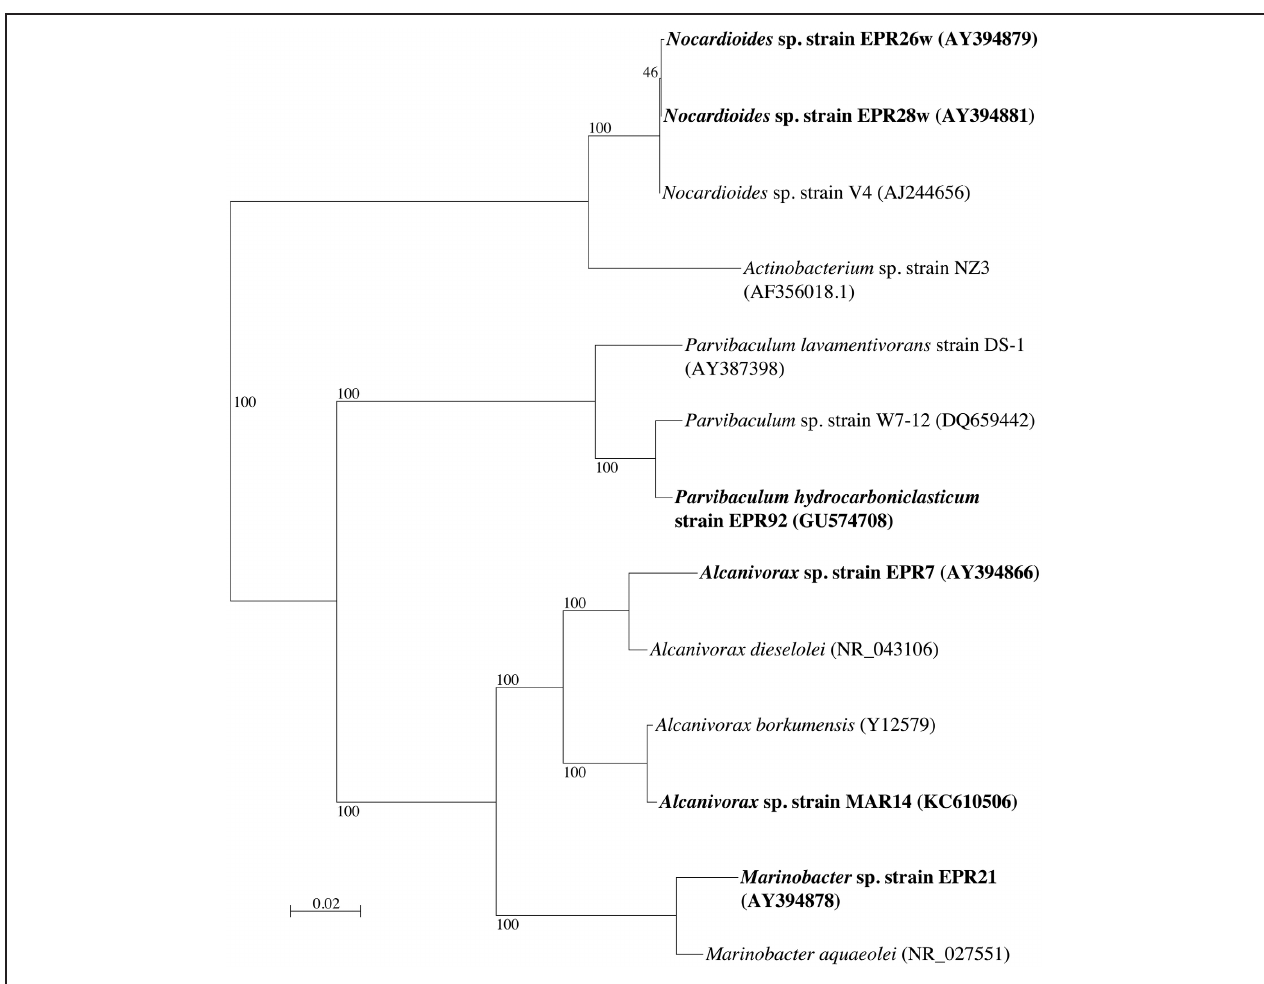
FIGURE 1 | Neighbor-joining phylogenetic tree inferred from 16S rRNA gene sequences, showing the position of the six deep-sea hydrothermal vent strains (in boldface) used in this study. The tree was constructed